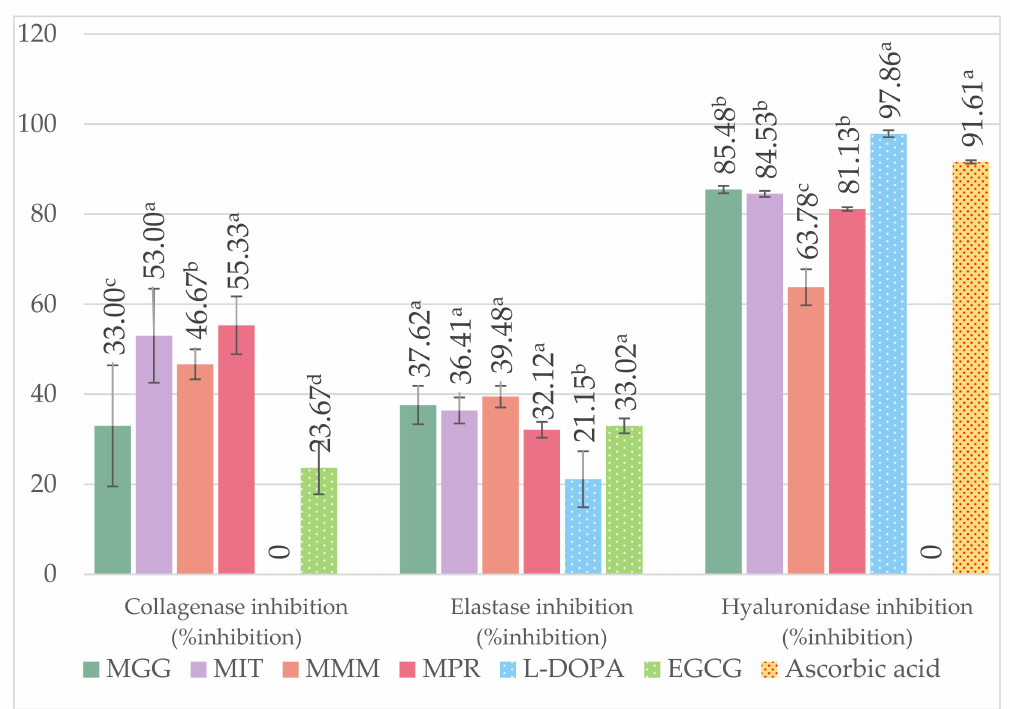
Figure 6. Collagenase, elastase, and hyaluronidase inhibitory activities of Mucuna seed extracts (concentrations 1 mg/mL). Values are expressed as mean ± SD ( n = 3); a, b, c, and d show significant differences among samples at p <